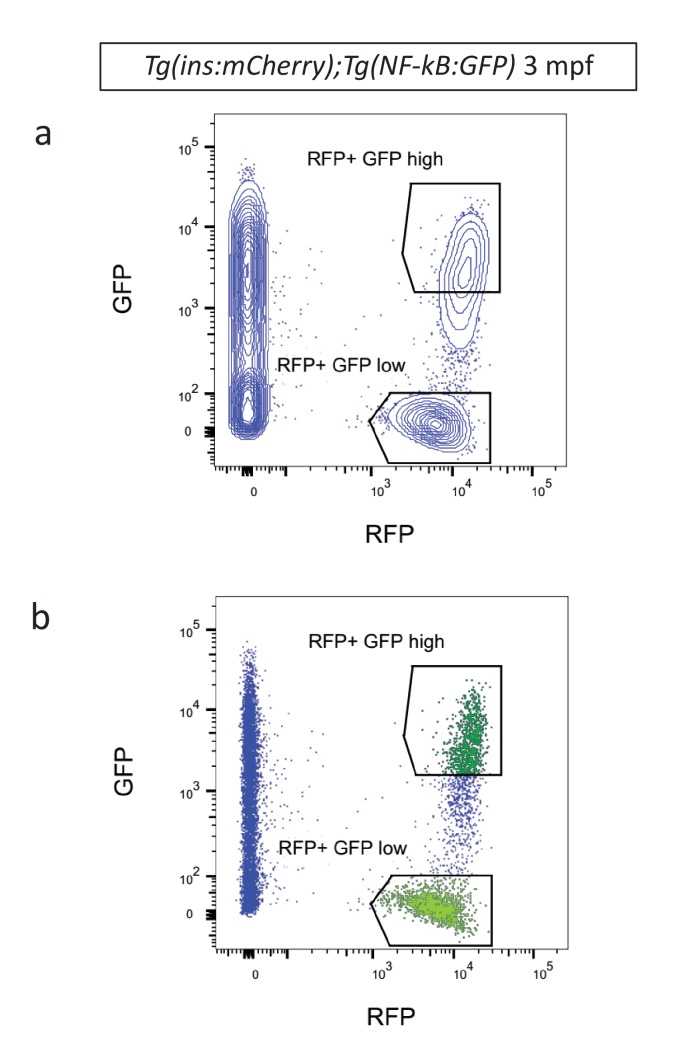
Fluorescent activated cell sorting of NF-kB:GFPhigh and NF-kB:GFPlowbeta-cells.(a) Contour plot showing FACS of live RFP-positive GFPhigh and GFPlow cells from Tg(NF-kB:GFP);Tg(ins:mCherry) animals at 3 mpf. Live cells were labeled with calcein. (b) Dot plot shows FACS of live RFP-positive GFPhigh and GFPlow cells from Tg(NF-kB:GFP);Tg(ins:mCherry) animals at 3 mpf.